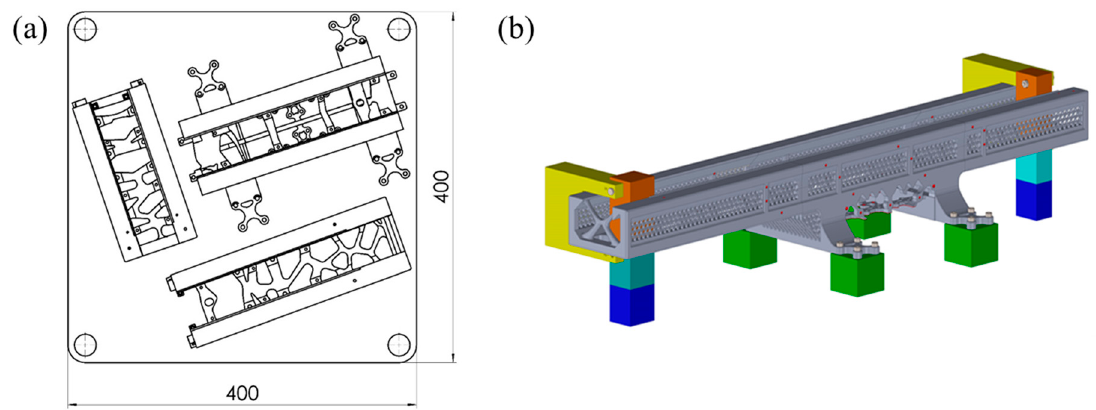
Figure 4. ( a ) manufacturing orientation for L-PBF production by EOS M400 and ( b ) machining using a three-axis machine.